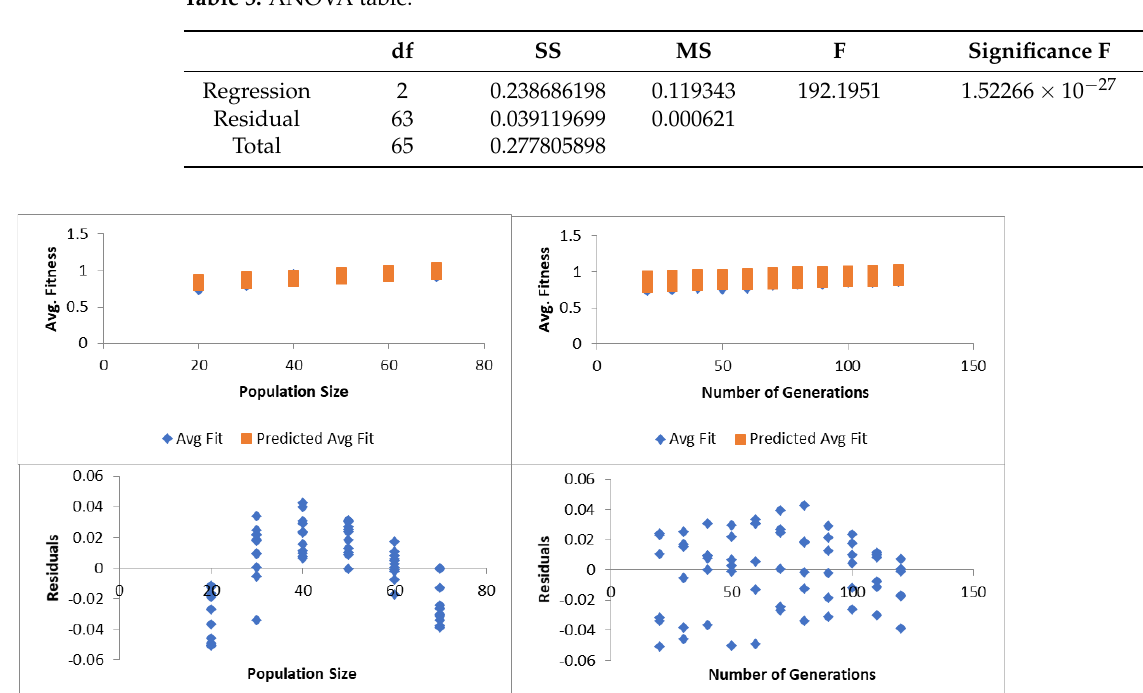
Figure 14. Boxplot for data distribution of ANOVA analysis.